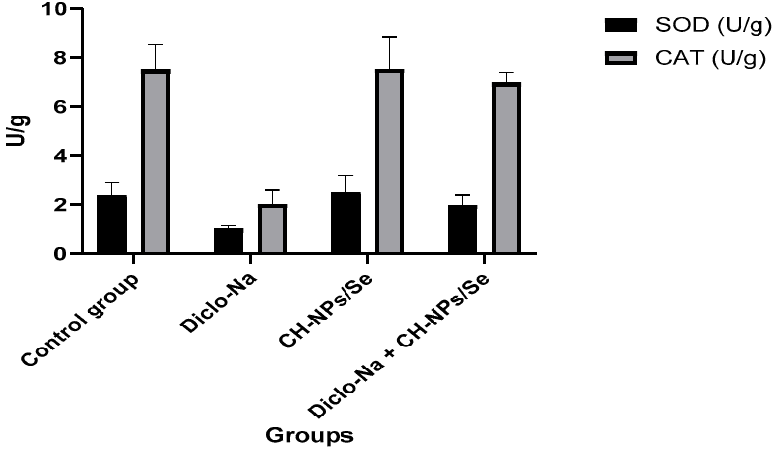
Figure 5. Effect of (CH-NPs/Se) on SOD and CAT activities in the testicular tissue of Di- clo-Na-treated rats.